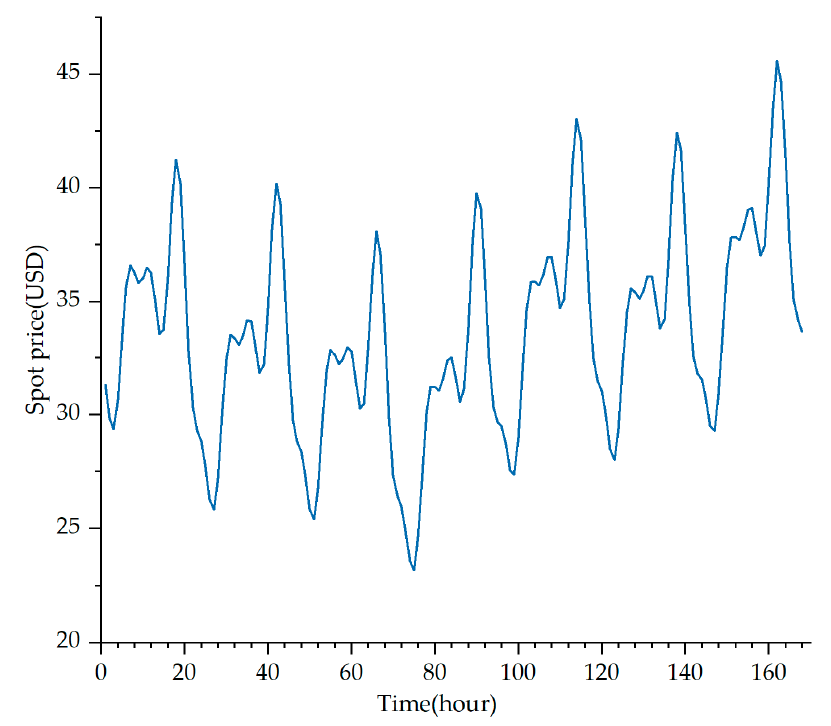
Figure 4. The spot price forecast.